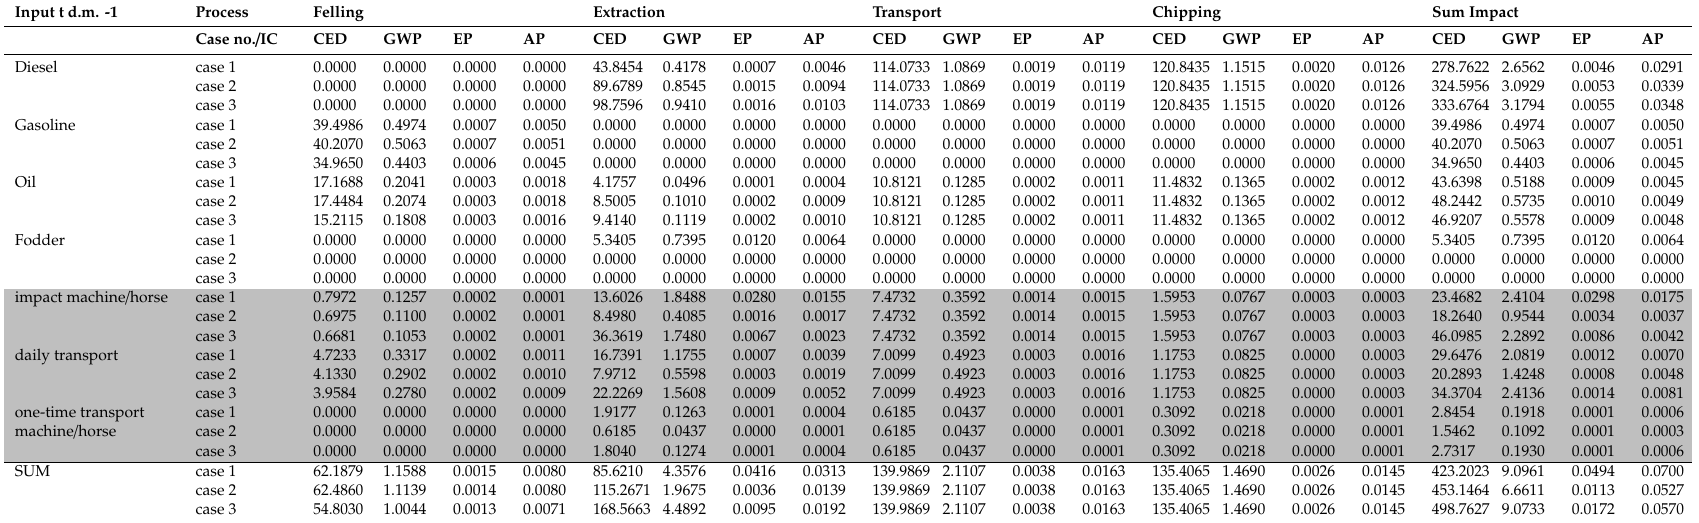
Table 6. Results table of life cycle impact assessment, in kg per ton d.m